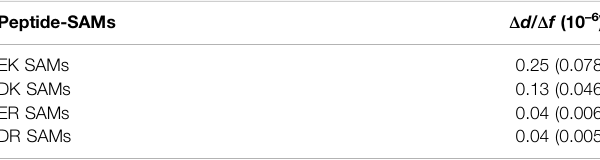
TABLE3| Δ d / Δ f of fi brinogenonthepeptide-SAMsinthePBSsolutionmeasured by QCM-D after the rinsing. Numbers in parenthesis are standard deviations (n (cid:2)